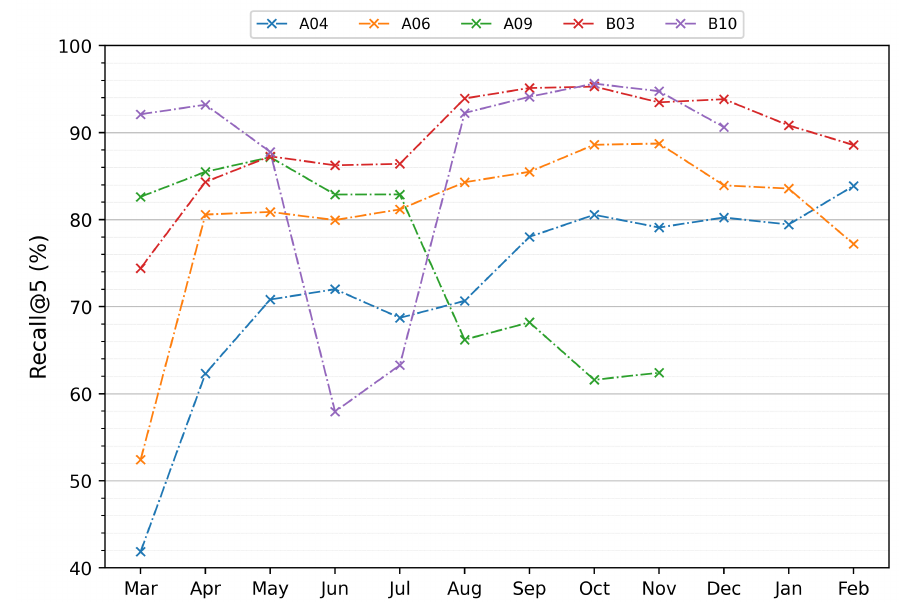
Figure 4. Recall@5 for each month for five users’ results using the NAP model.